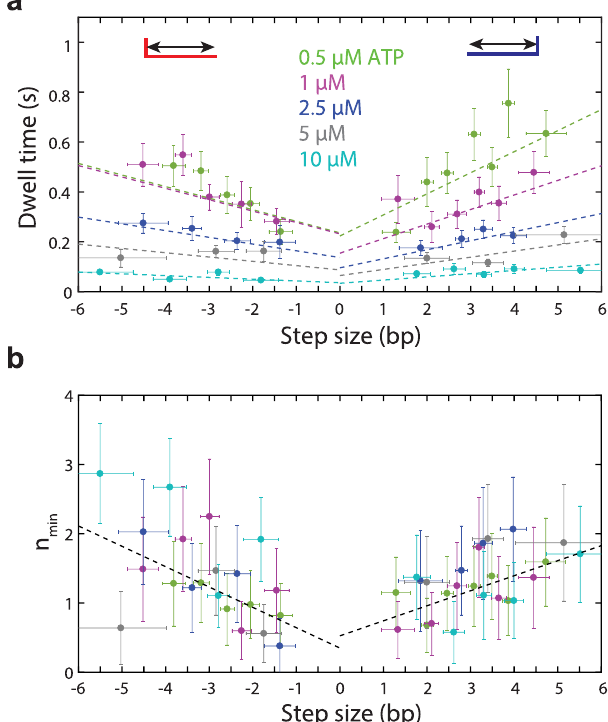
Fig. 4 Dwell time statistics reveal that ATP binding and the number of rate-limiting steps depends on step size. a Average dwell times between successive unwinding (denoted as + / + , shown as positive step sizes) and re-zipping (denoted as − / − , shown as negative step sizes) step pairs vs the size of the step following the dwell, across ATP concentrations (color coded as indicated). Dotted lines represent fi ts to linear trendlines, obtained by scaling the fi ts of the normalized dwell times vs step size in Supplementary Fig. 10 by the normalization factors at each ATP. b Minimum number of rate-limiting steps, n min , for + / + and − / − step pairs vs the size of the step following the dwell, across ATP concentrations. Dotted lines represent fi ts to linear trendlines, as described in the text. Vertical error bars denote standard errors and represent the best estimate of the error on mean dwell time and n min . Horizontal error bars denote standard deviation and represent the spread in the measured step size (see “ Methods ” ). Total number of dwells contributing to plots in ( a ) and ( b ): N = 214, 156, 113, 84, 153 ( + / + ) and 162, 128, 105, 83, 193 ( − / − ) from 25, 16, 12, 12, 12 traces at [ATP] = 0.5, 1, 2.5, 5, 10 μ M, respectively. Source data are provided as a Source Data fi